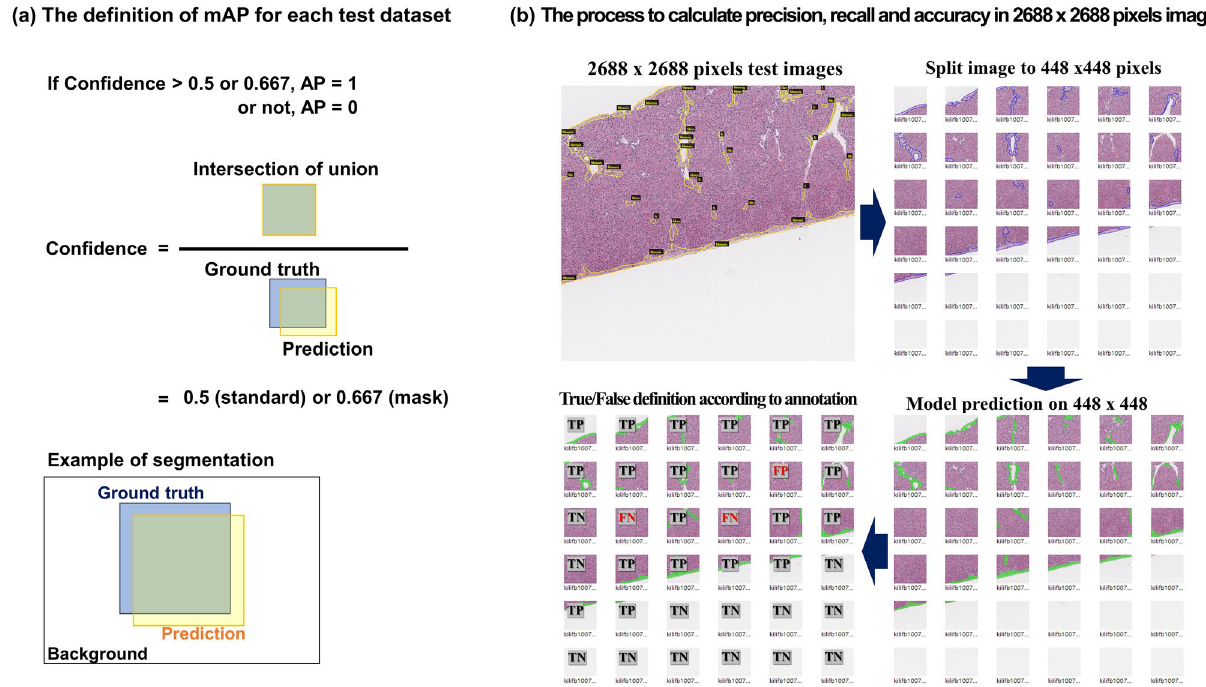
Figure 2. The definition of mAP used to assess the accuracy of trained models using test datasets ( a ). The process to calculate the precision, recall, and accuracy in order to evaluate each model’s performance in real- world data ( b